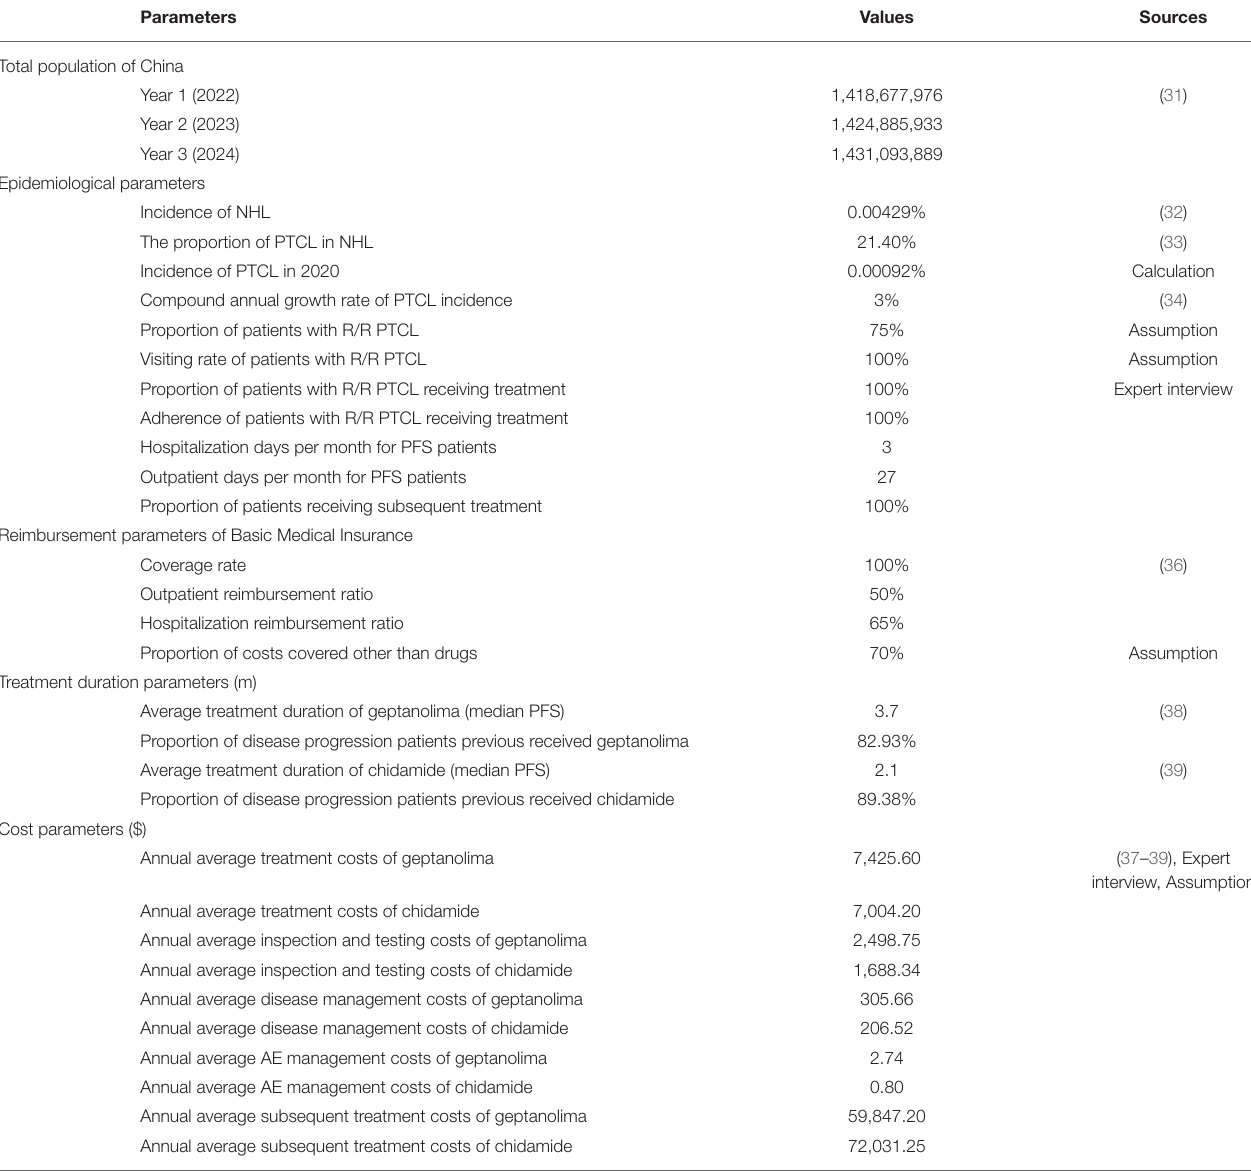
TABLE 1 | Model inputs of budget impact model. Parameters Values